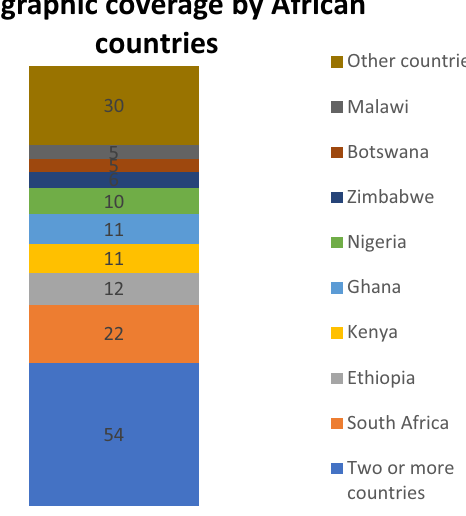
Fig. 2 Geographic coverage of studies by countries